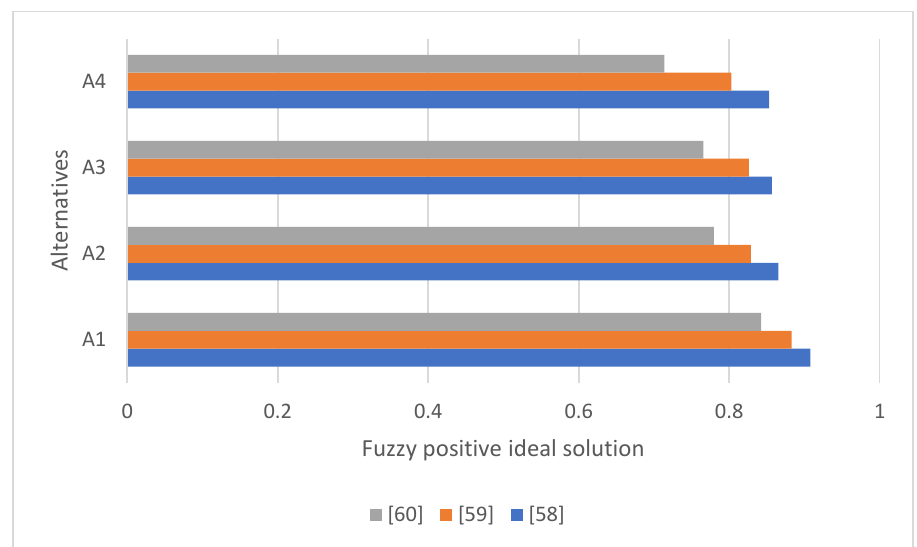
Figure 6. Calculation of Fuzzy positive ideal solution according to [58 – 60].